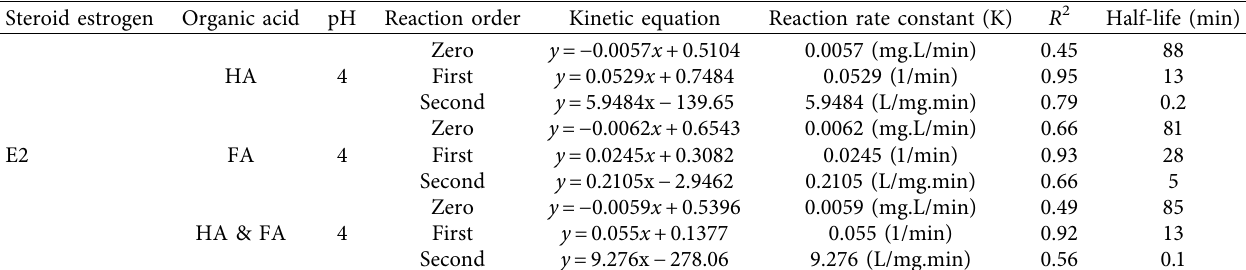
Table 5: Degradation kinetic parameters of E2 in presence of HA for acidic and neutral pH. Steroid estrogen Organic acid pH Reaction order Kinetic equation Reaction rate constant (K)